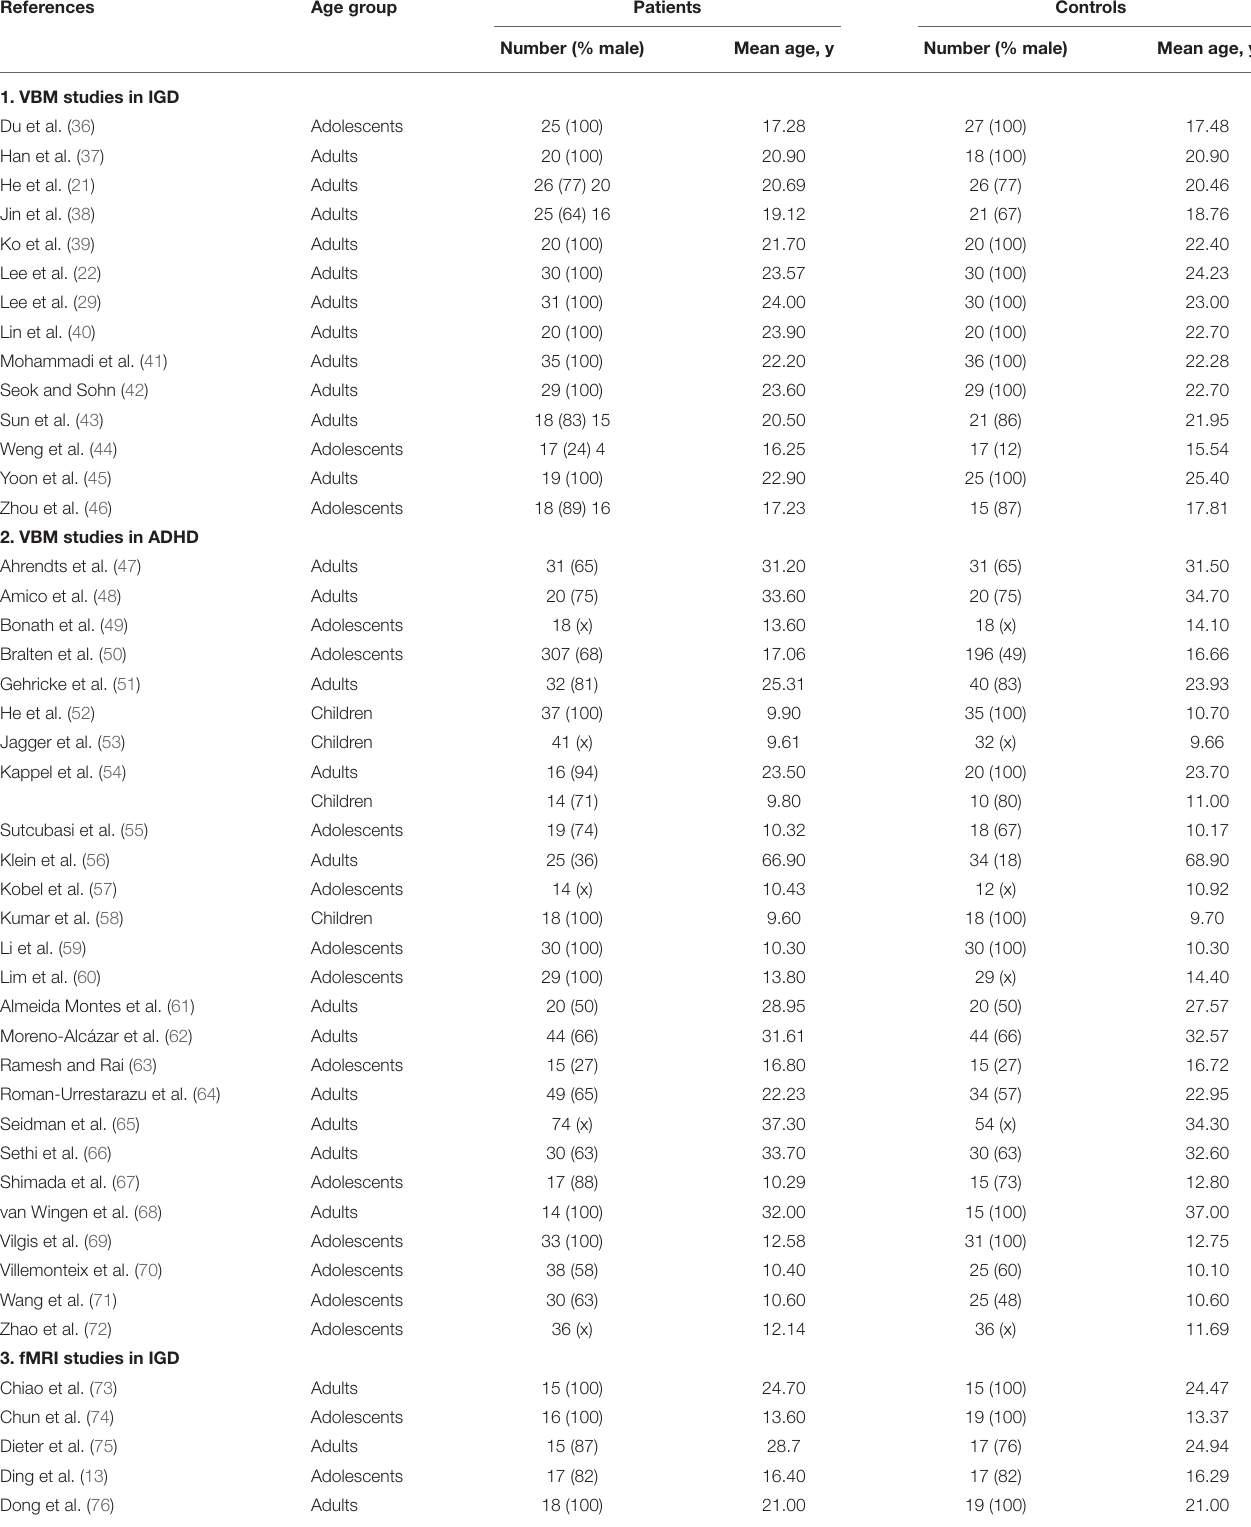
TABLE 1 | Sample characteristics of VBM and fMRI studies in IGD and ADHD